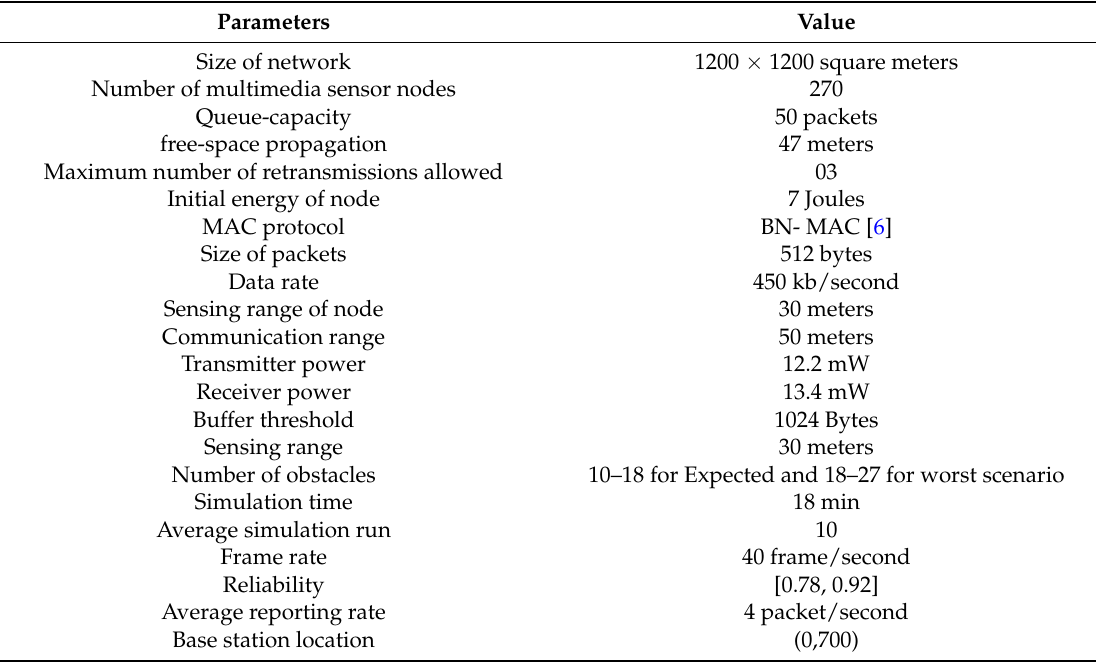
Table 4. Simulation parameters and its corresponding